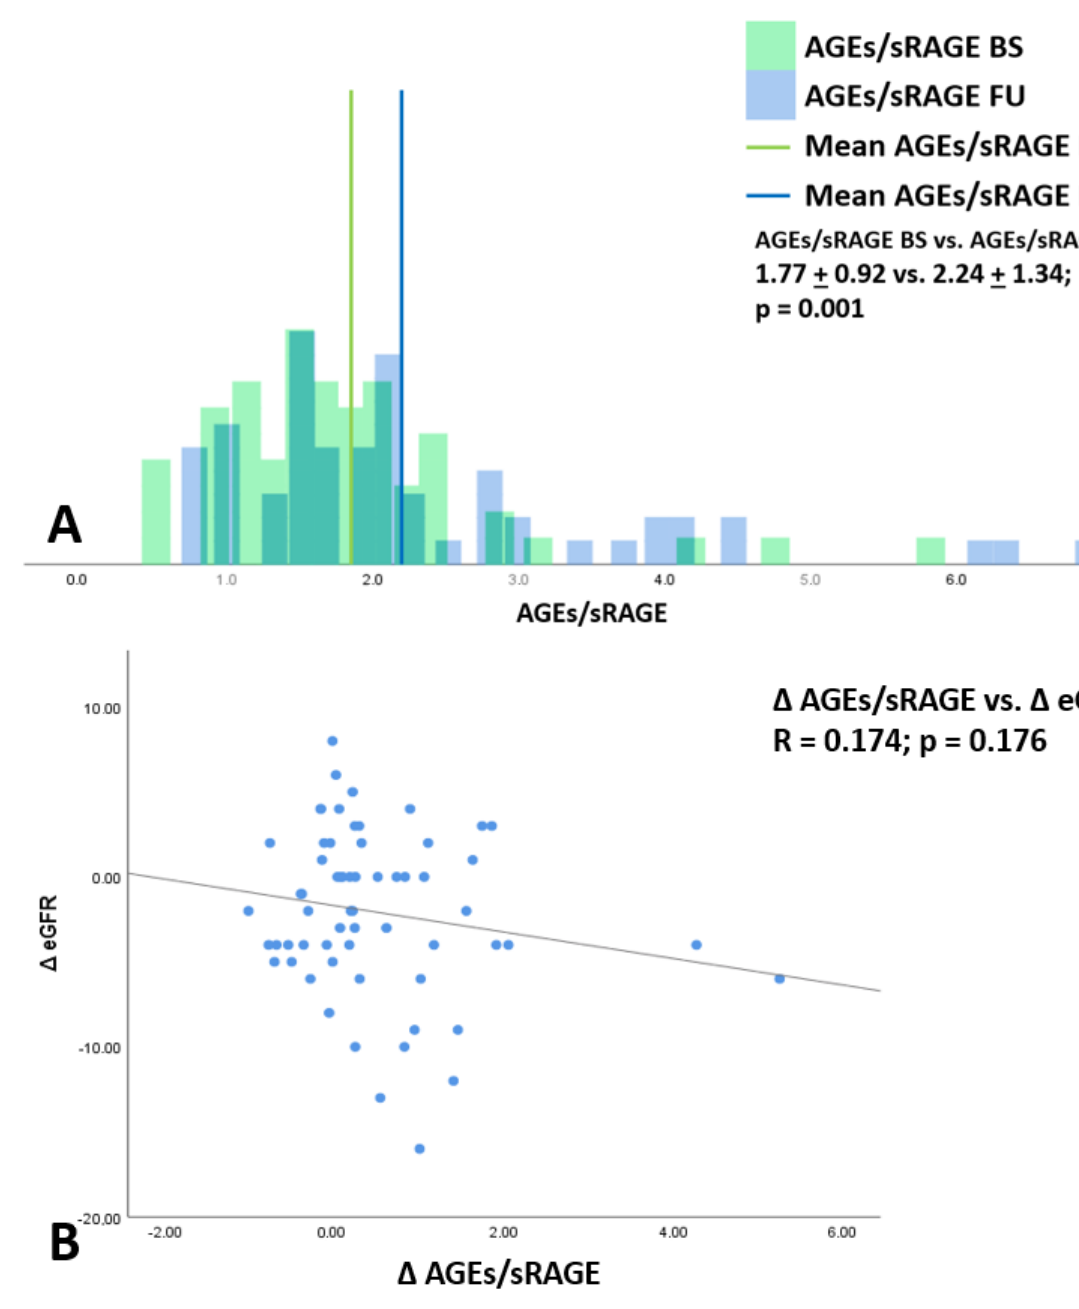
Figure 4. Distribution of advanced glycation end products/soluble receptor for advanced glycation end products ratio. AGEs/sRAGE at baseline and follow-up (panel ( A )). Linear regression analysis between the differences (basal–FU) of ∆ AGEs/ ∆ sRAGE and eGFR ( ∆ eGFR) (panel ( B )). BS: baseline; FU: follow-up; AGEs: advanced glycation end products; sRAGE: soluble receptor for advanced glycation end products receptor; eGFR: estimated glomerular filtration rate.